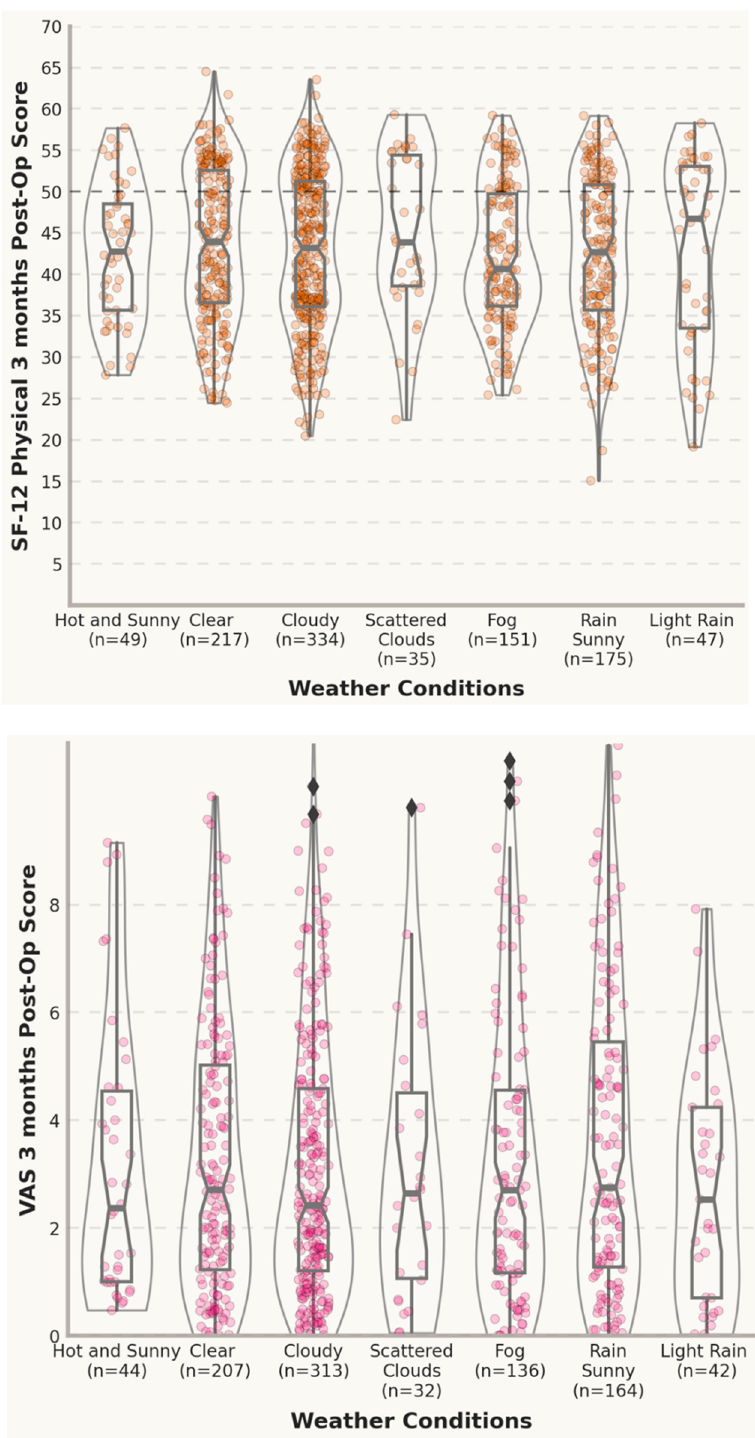
Figure 4. Post-operative scores under different weather conditions (3 months). Standardized scoring 50 ± 10 (mean ± SD) [34–35].